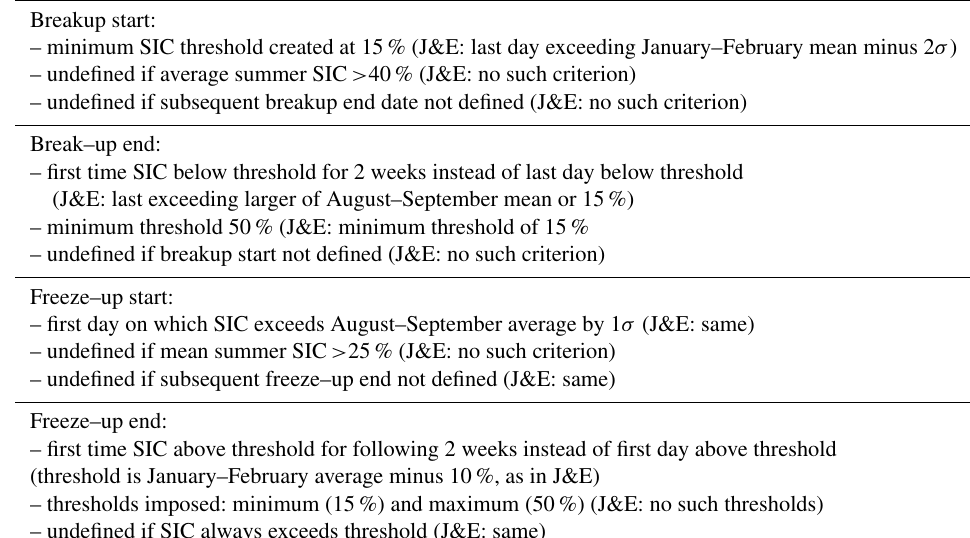
Table 2. Changes in the indicator definitions relative to Johnson and Eicken (2016), denoted as “J&E”. The symbol “ σ ” denotes standard deviation; “SIC” denotes sea ice